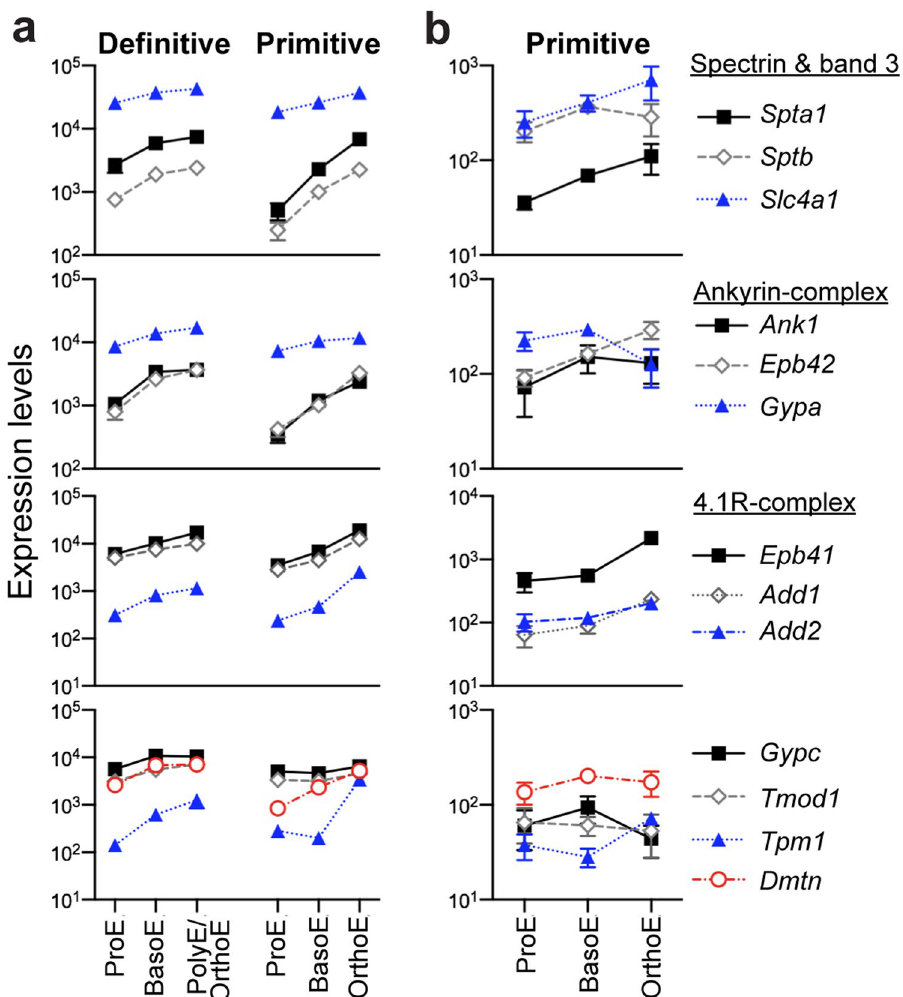
Figure 2. Major cytoskeletal genes are already expressed in ProE and transcript accumulation increases during maturation of primary murine primitive and definitive erythroid cells. ( a ) Relative transcript levels of cytoskeletal genes in primary definitive (left panel) and primitive (right panel) erythroblasts isolated from adult bone marrow and from staged embryos (ErythronDB: www.cbil.upenn.edu/ErythronDB) 16 . ( b ) Expression of cytoskeletal genes in purified maturing primitive erythroblasts was examined using quantitative real-time PCR. At least three independent experiments were performed at each gestational stage. Error bars represent